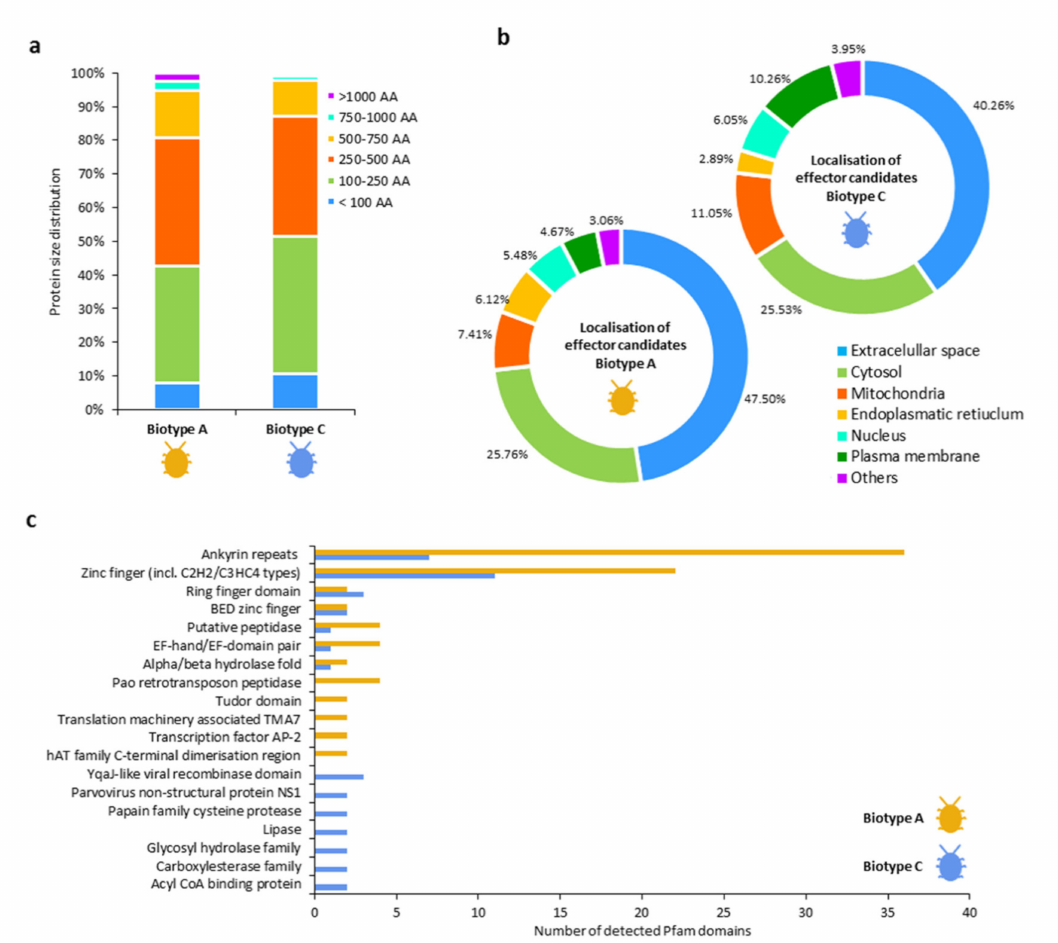
Figure 4. Characterization of e ff ector candidates between feeding grape phylloxera biotype A and C, where two sets of DEGs coding for secreted proteins in the two grape phylloxera biotypes were analyzed. ( a ) Protein length distribution [AA]; ( b ) localization analysis of the grape phylloxera proteins within the insect. The results corresponded to the cellular compartment with the highest localization probability of each analyzed protein predicted by WoLF PSORT; ( c ) results of the Pfam analysis detecting functional protein domains between